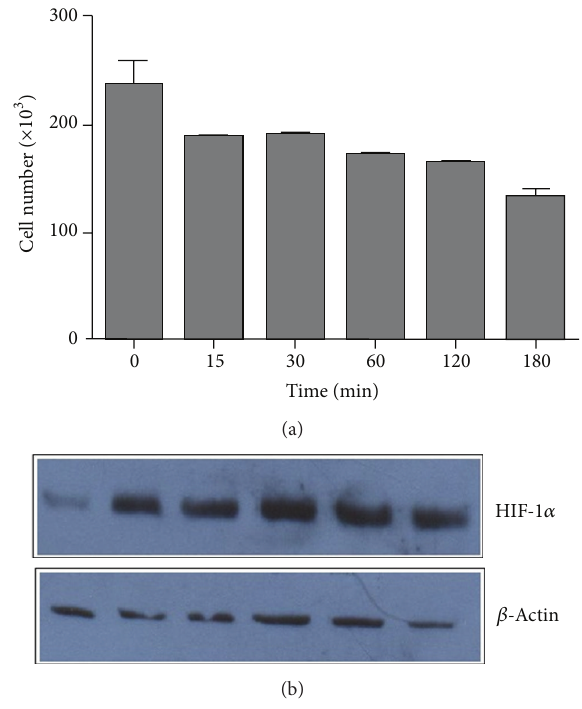
Figure 1: Induction of cell death by the coverslip hypoxia model. (a) Coverslips were placed onto confluent cardiac myocyte mono- layers and removed after 15, 30, 60, 120, and 180 min. As a negative control, myocyte cultures were left uncovered. Cell viability was evaluated by the MTT assay. Data represent the average of three independent tests. Error bars indicate the standard error of the mean. (b) Proteins in whole cell lysates obtained at the indicated time points were analyzed for HIF-1 𝛼 expression by immunoblot- ting. As a control, the expression of the constitutive 𝛽 -actin protein was